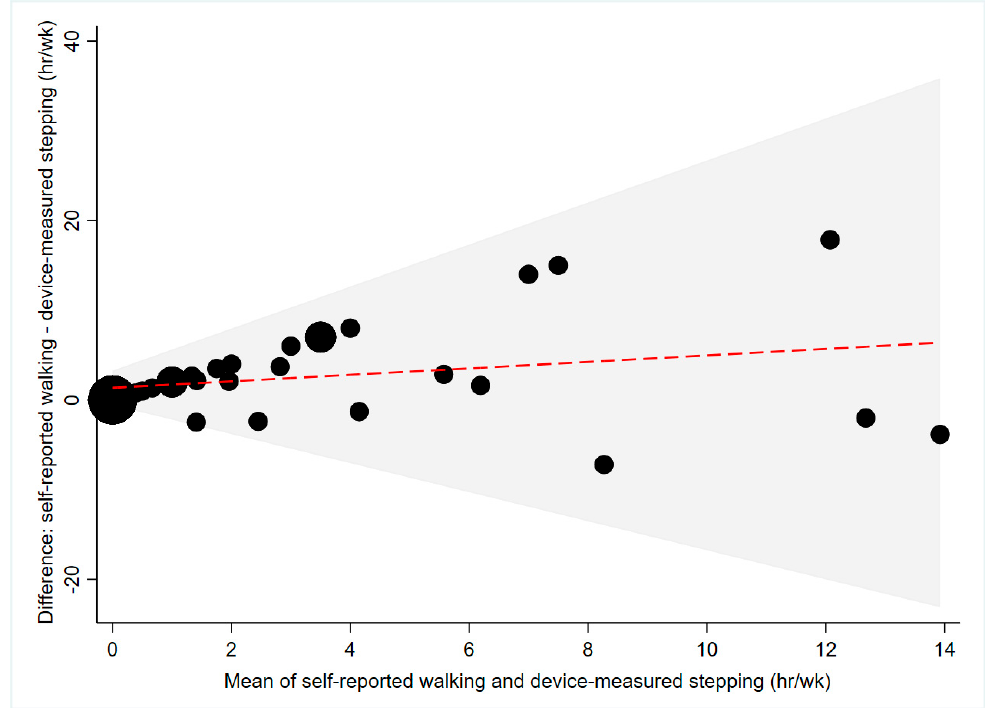
Figure 2. Agreement between self-reported and device-measured walking/stepping time ( n = 40). The red line represents the mean difference, the grey shaded area represents the limits of agreement and the size of the black dots differs depending on the number of participants that correspond to that value. Table 3. Average mean difference (over/under-estimation) between the International Physical Activity Questionnaire–Short Form and device measured physical activity and sitting time.